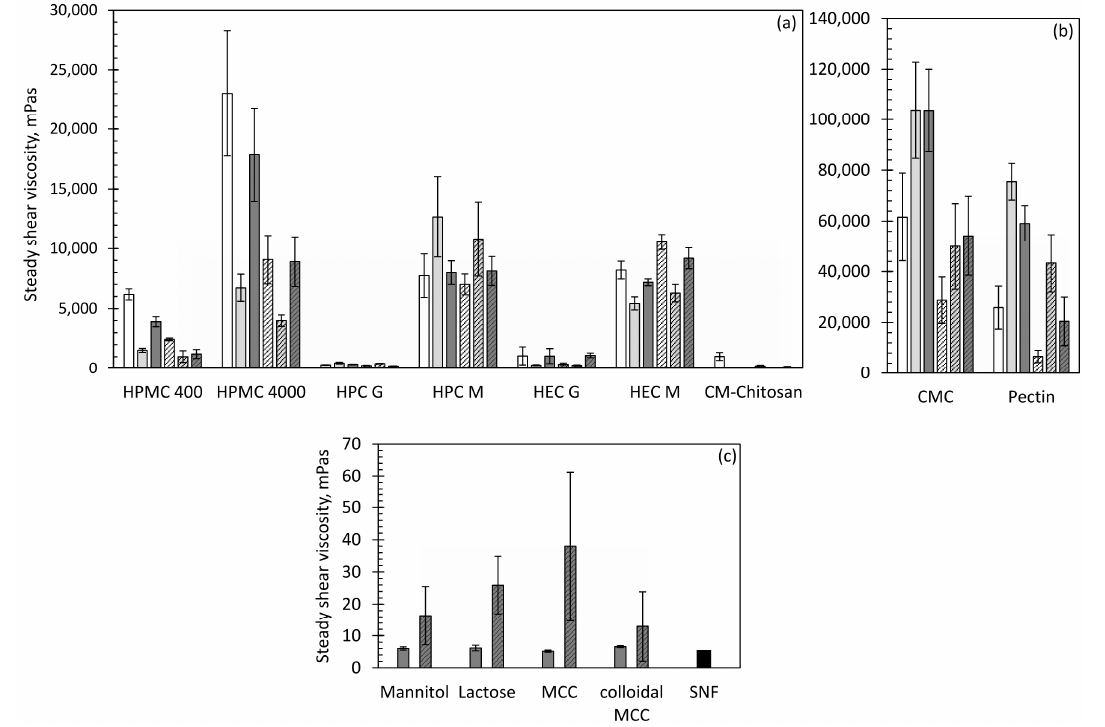
Figure 2. ( a , b ) Particle size-dependent steady shear viscosity at 1 Hz of the mucoadhesive polymers (2% in SNF). The white bars represent the sieve fraction (SF) 32–90 µ m: light grey bars, SF 90–150 µ m; dark grey bars, SF 32–150 µ m. For better visibility, the data is presented in two graphs with different scaling of the y-axis. ( c ) Steady shear viscosity at 1 Hz of the fillers (SF 32–150 µ m). ( a – c ) The plain bars show the steady shear viscosity after 1 min, and the striped bars after 15 min. n = 3; error bars = sd.